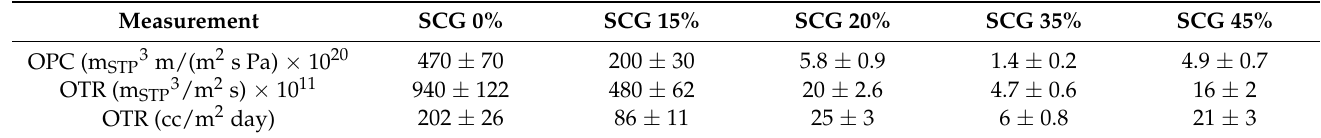
Table 2. OPC and OTR measurements results for different packaging films at different SCG concen- tration, from 0% to